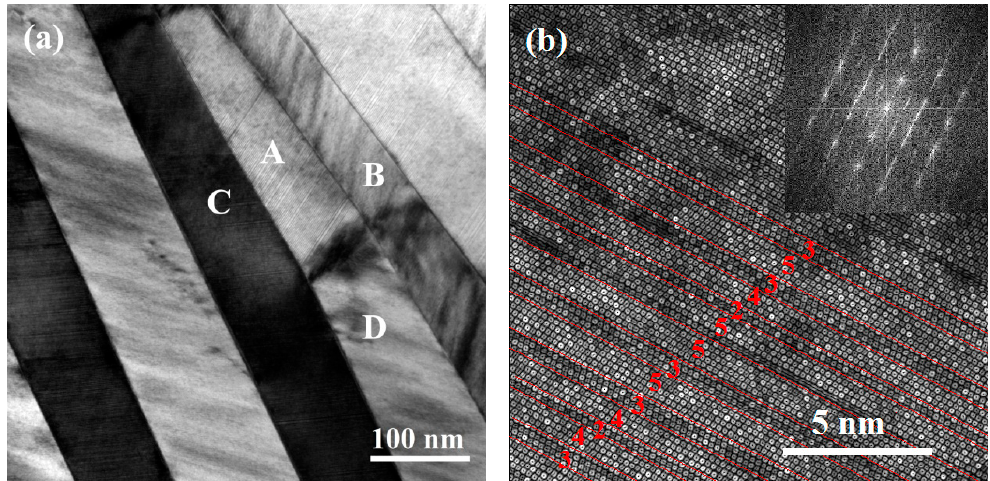
Figure 4. ( a ) TEM bright-field image of modulated martensite plates. ( b ) High-angle Annular Dark-field (HAADF) atomic image along <0 1 0> M in one martensite plate of melt-spun